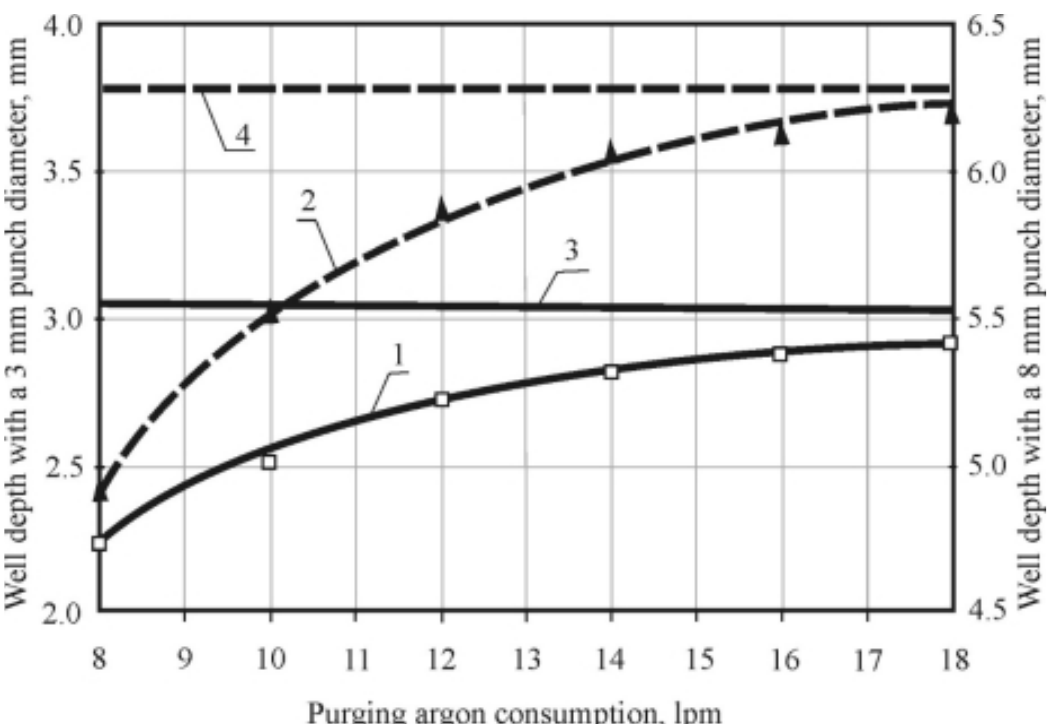
Figure 8. Influence of purging argon consumption on the results of the Erikson test: 1, 2 – seam, ø 3 mm and ø 8 mm, respectively; 3, 4 – base metal, ø 3 mm and ø 8 mm, respectively.